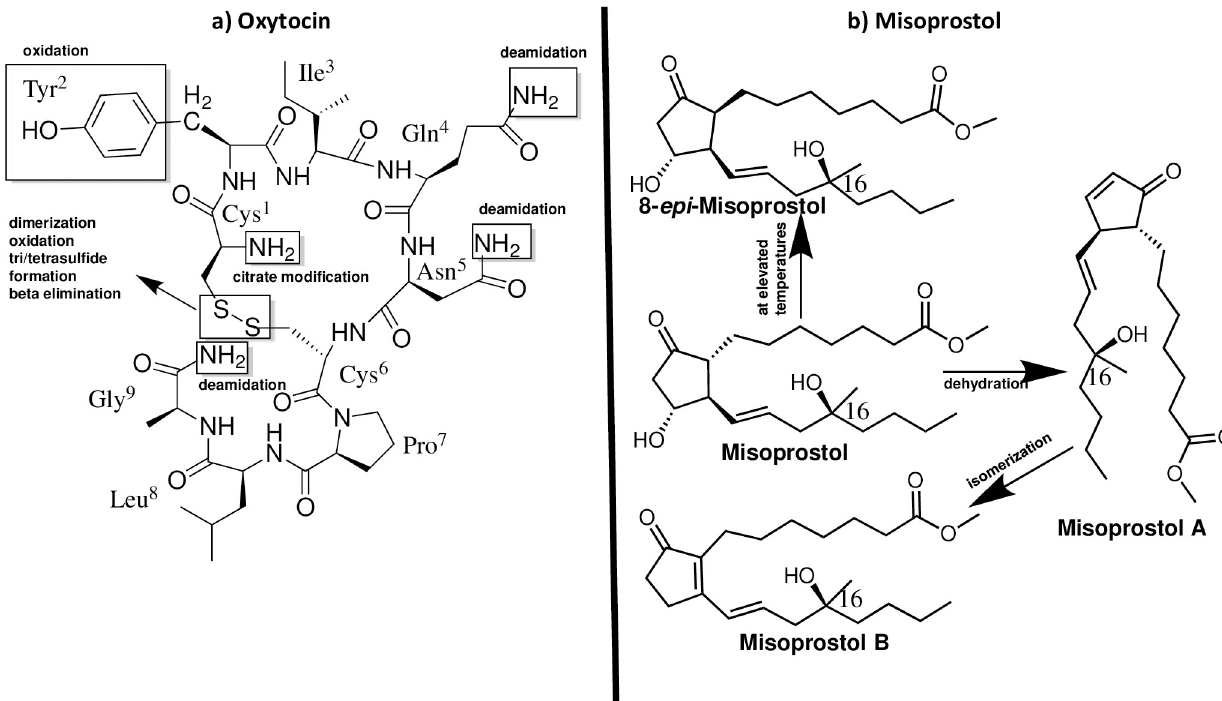
Fig 1. Structures of oxytocin (modified from [21]) and misoprostol, and their typical degradation mechanisms. Commercial misoprostol is a mixture, containing the depicted structure, its epimer at C16, and the enantiomers of both compounds. Likewise, the degradation products of misoprostol contain the corresponding